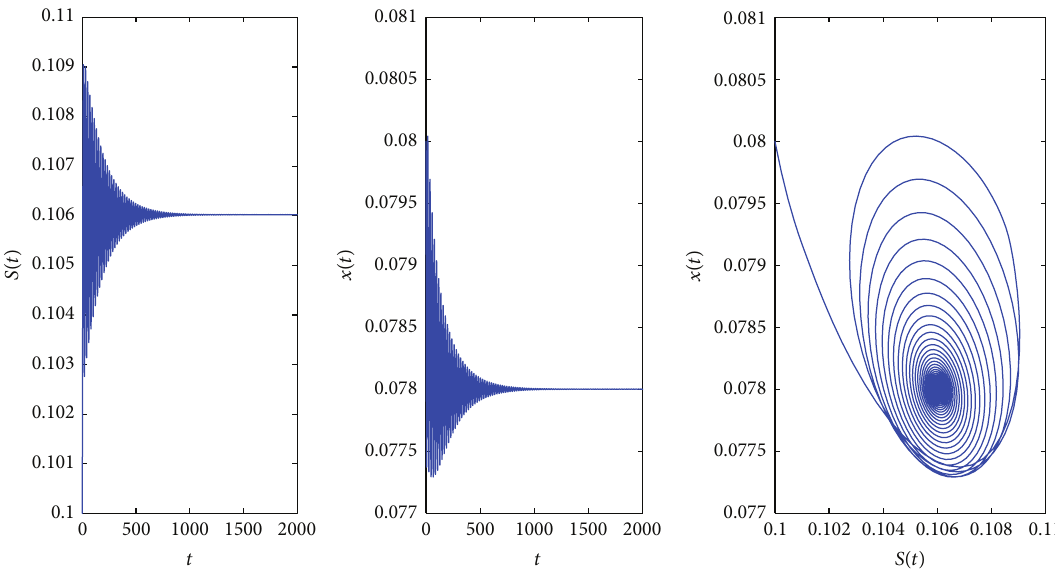
Figure 4: Asymptotic stability. The steady state 𝐸 ∗ of (1) is locally asymptotically stable, even though damped oscillations can be observed. Parameters are 𝐷 = 0.01 , 𝐷 1 = 0.5 , 𝛾 = 0.8 , 𝑘 = 0.1 , 𝑎 = 1 , and 𝑆 0 = 1 . The time delays are 𝜏 1 = 0.9 and 𝜏 2 = 12.217